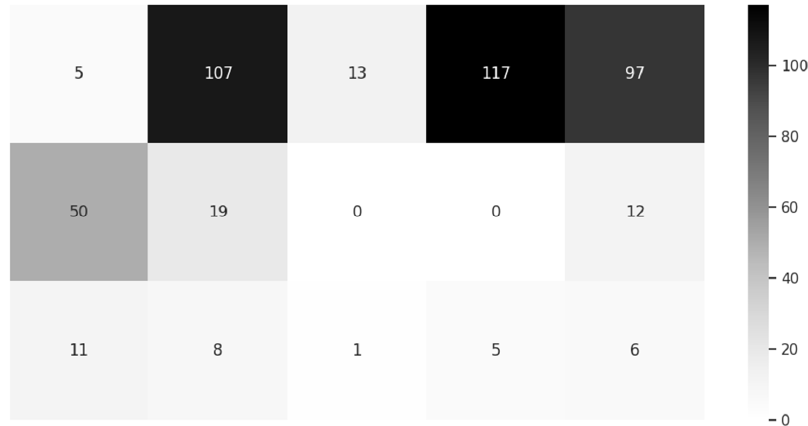
Figure 18. The heatmap of rest time (minutes) in nightly groupings (user2).